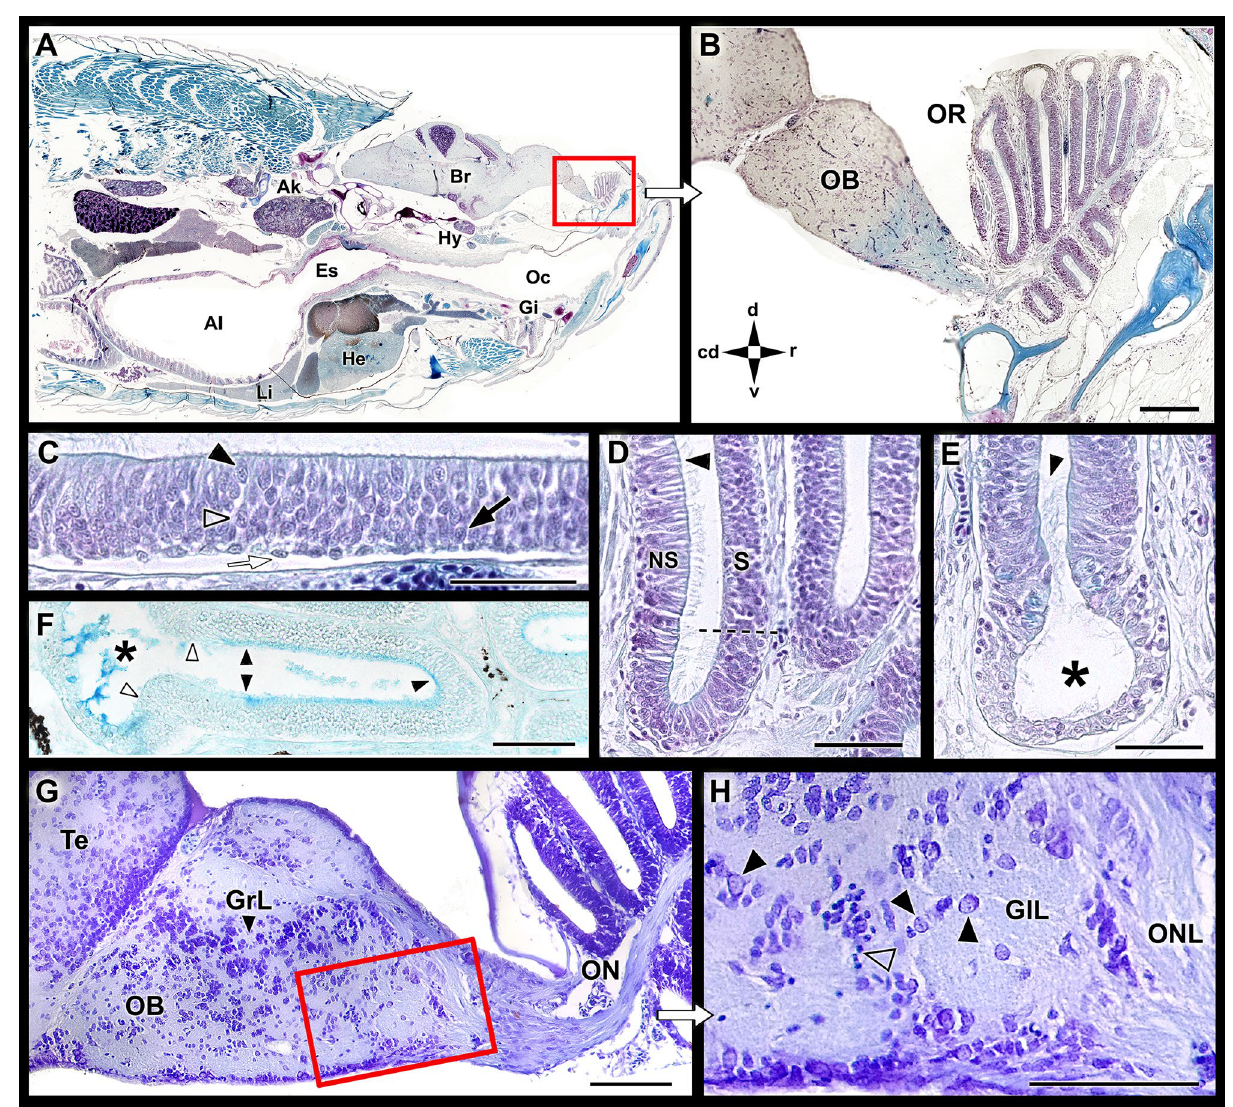
Figure 2. Microscopic anatomy of the zebrafish olfactory system. ( A ) Low power sagittal section of the anterior zebrafish stained with Gallego’s trichrome. ( B ) Higher magnification of the inset in ( A ), showing the olfactory rosette and the olfactory bulb (OB). ( C ) Histological section of the olfactory sensory epithelium stained with Gallego’s trichrome. Black arrowhead, crypt cell; open arrowhead: microvillous cell; back arrow, ciliated cell; white arrow: basal cell. ( D ) Histological section of the medial side of the lamellae. The dotted line demarcates the nonsensory epithelium (NS) of the olfactory epithelium (S). Arrowhead, ciliated cells in the nonsensory epithelium. ( E ) The lateral rim of the lamellae-forming channel-like system (asterisk). Arrowhead, ciliated nonsensory cells. ( F ) Histological section of the lamellae stained by Alcian Blue. The luminal mucociliary complex is restricted to the sensory area (black arrowheads). The nonsensory epithelium border is free from acid mucins (white arrowheads), but Alcian Blue-stained secretions are concentrated inside the channel. ( G ) Sagittal section of the olfactory bulb. ( H ) Inset from ( G ) showing the olfactory nerve layer (ONL) and the glomerular layer (GlL). Black arrowhead, mitral cells; open arrowhead, periglomerular cells. Stains: ( A – E ) Gallego’s trichrome; ( F ) Alcian Blue; ( G , H ) Nissl stain. Ai, anterior intestine; Ak, anterior kidney; Br, Brain; Es, esophagus; Gi, gilts; GrL, granular layer; He, heart; Hy, hypophysis; Li, liver; Oc, oral cavity; OR, Olfactory rosette; Te, telencephalon; cd, caudal; d, dorsal; r, rostral; v, ventral. Scale bars: 100 µm ( B , G , H ); 50 µm ( C – F The results of the immunohistochemical study with anti-calbindin (anti-CB) and anti-calretinin (anti-CR) are depicted in Fig. 4A,B,D,E and C,F respectively. Both markers label a subpopulation of olfactory sensory neurons. Sagittal and transverse sections of the rosette show how the anti-CB inmmunolabelling is mostly located in the deeper part of the neurosensorial epithelium (Fig. 4D), whereas the nonsensory epithelium is Anti-CB immunon- egative (Fig. 4B). Anti-CR immunolabelling produces a stronger labelling than anti-CB in neuroepithelial cells, which is mostly concentrated in the medial part of the lamellae (Fig. 4C), and their deeper neuroepithelial layers (Fig. 4F). Very rarely superficial cells are immunolabelled. The nonsensory cripts do not show anti-CR labelling.